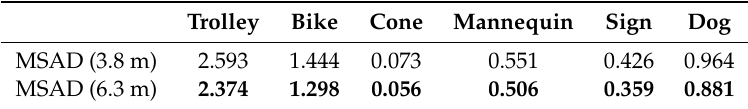
Figure 6. Comparing the real data at 6.3 m with the RADIO augmented data. Table 2. Mean sum of absolute differences (MSAD) between the real and augmented images at 3.8 m and 6.3 m, generated from real data at 3.8 m